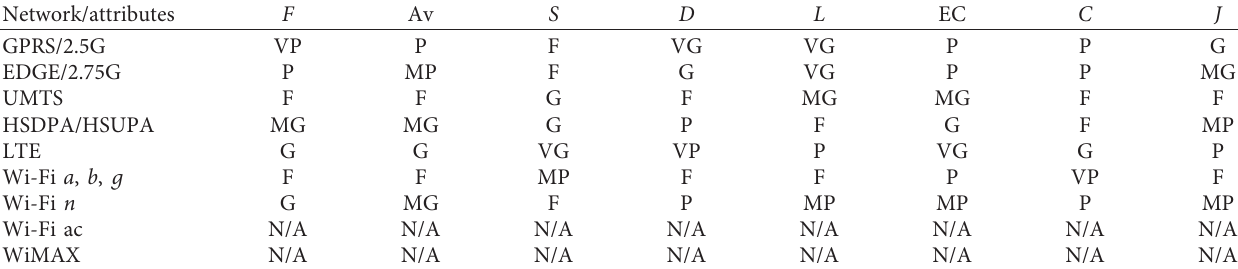
Table 8: An example of a linguistic values cell in a defined decision point from the fuzzy dataset.